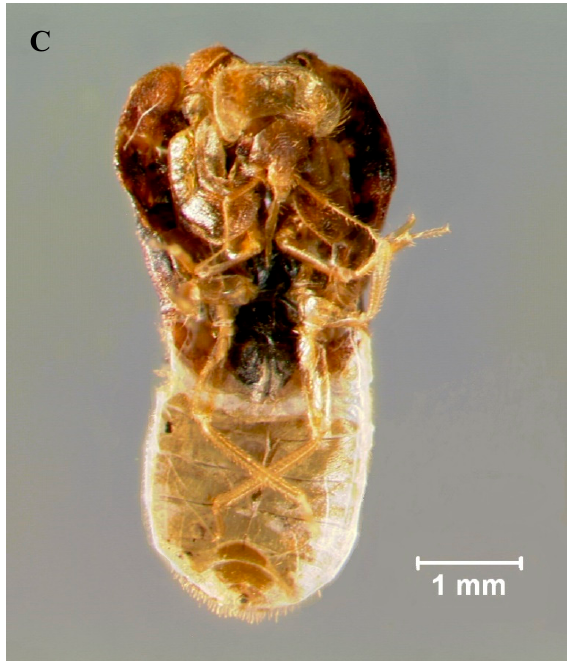
Figure 2. Photographs showing the lethal effects of lufenuron following ecdysis of treated 5th instar Harlan bed bugs with a dose of 16% ( w / v ) lufenuron. ( A ) A fully molted adult bed bug that died shortly after emerging from the exuvia; ( B ) A fifth instar that died during the process of molting with an extrusion of internal stomach structures; ( C ) A fifth instar bed bug that died during the molting process and could not fully emerge from its exoskeleton.